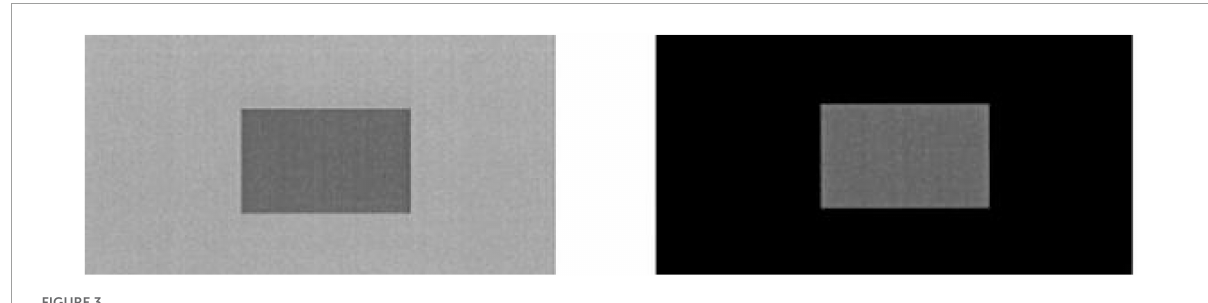
FIGURE3 Visual renderings in different